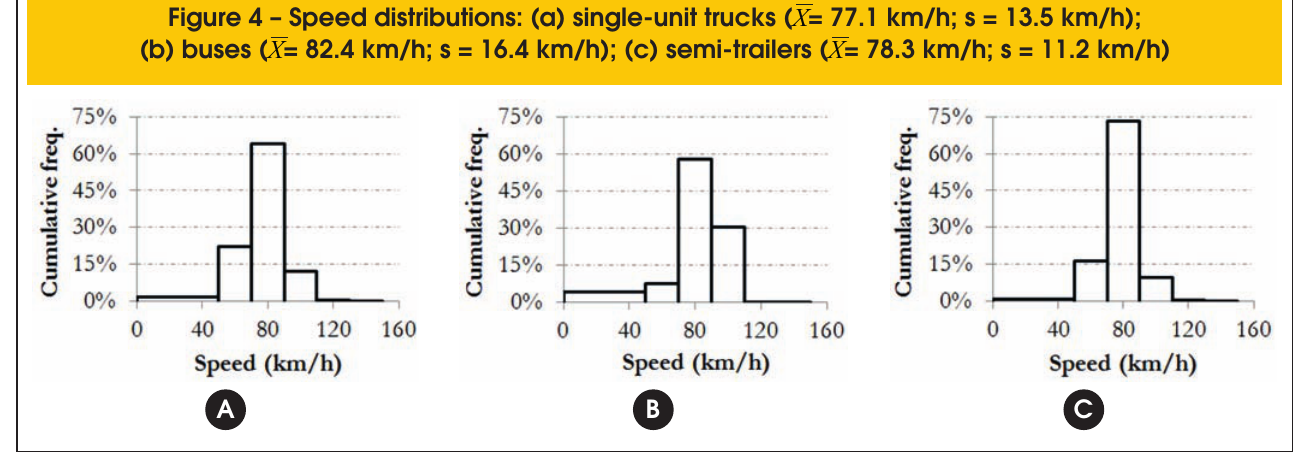
Figure 4 – Speed distributions: (a) single-unit trucks ( = 77.1 km/h; s = 13.5 km/h); X (b) buses ( = 82.4 km/h; s = 16.4 km/h); (c) semi-trailers ( = 78.3 km/h; s = 11.2 km/h)